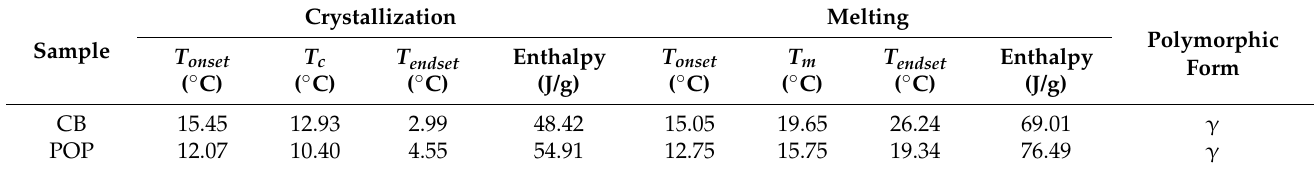
Table 2. Crystallization and melting profiles of CB and POP standard polymorphism at 5 ◦ C min − 1 .